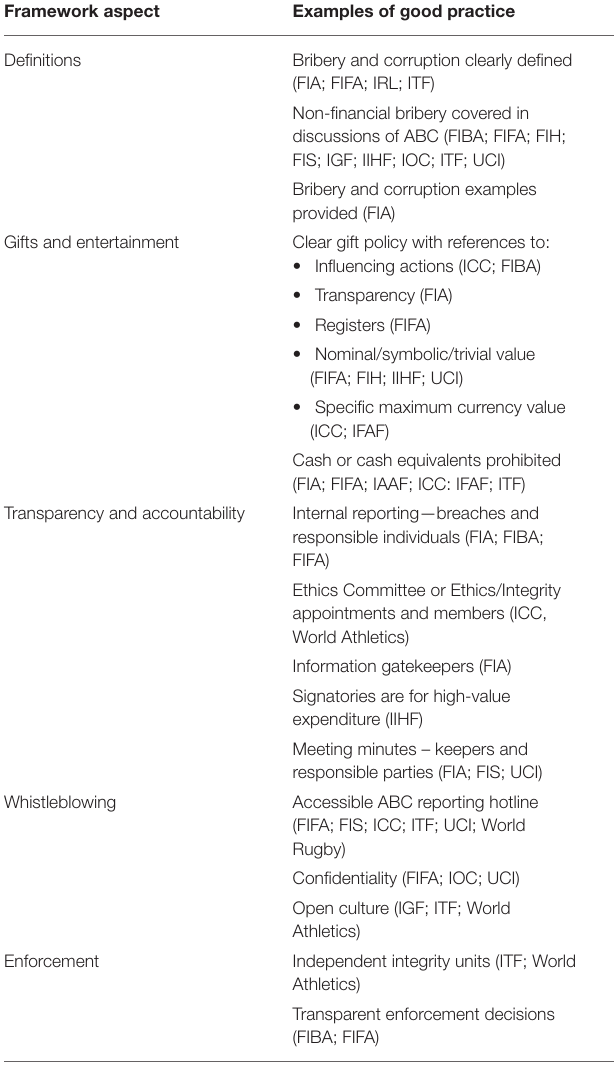
TABLE 4 | Examples of good